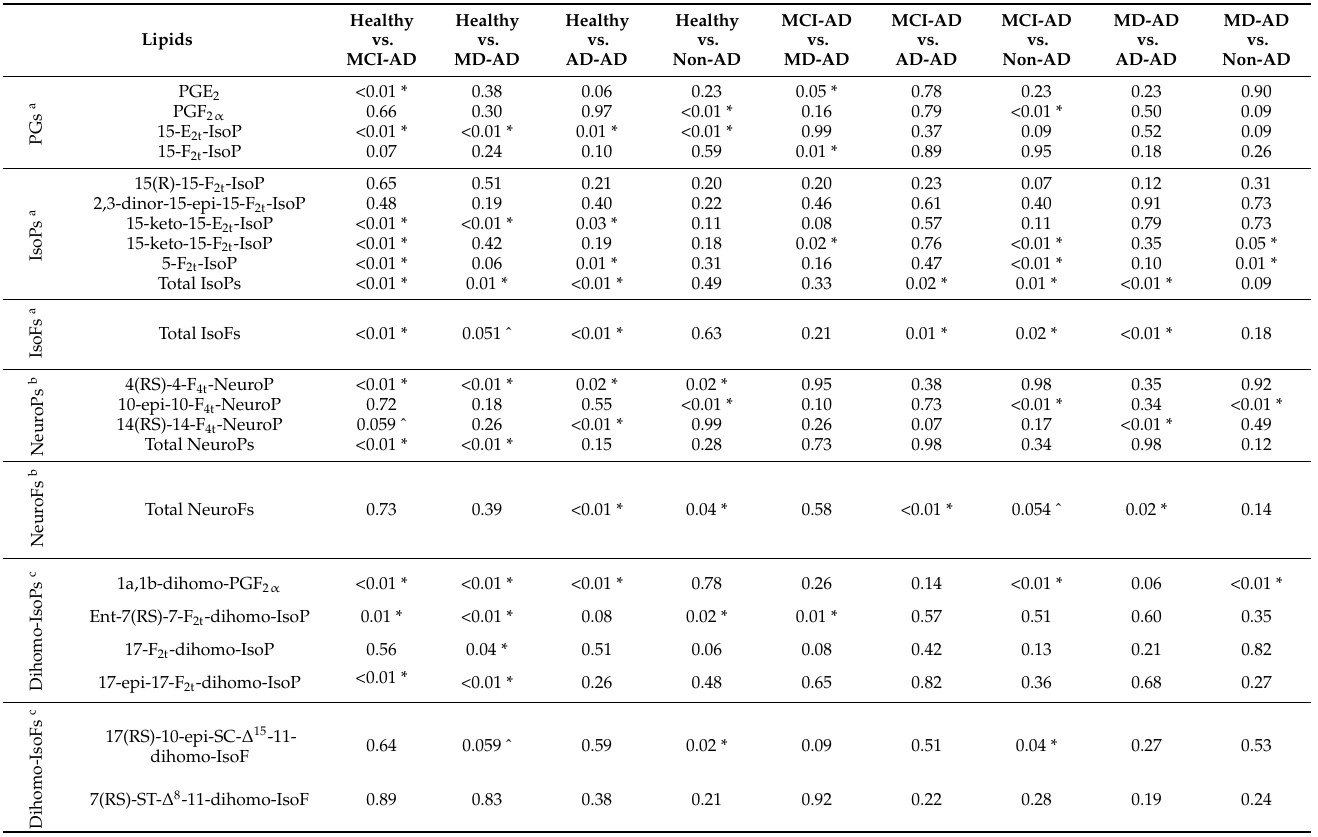
Table 4. Comparison of lipid peroxidation compounds between groups using Mann–Whitney test. MCI-AD